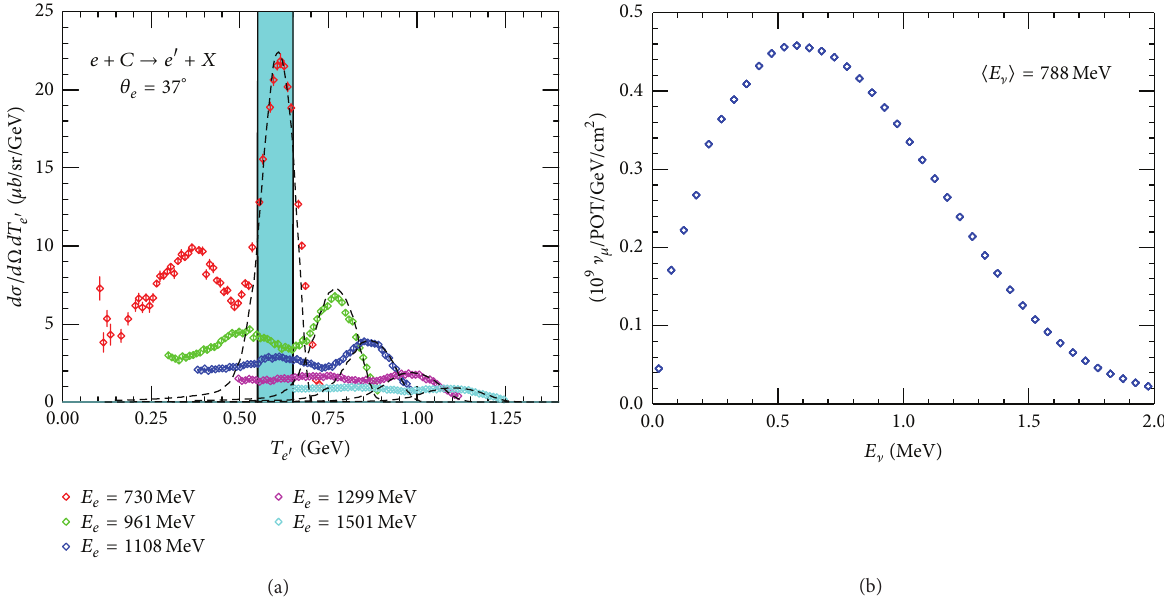
Figure 2: (a) Inclusive electron-carbon cross-sections at 𝜃 𝑒 = 37 ∘ and beam energies ranging between 0.730 and 1.501 GeV [3, 4], plotted as a function of the energy of the outgoing electron. (b) Energy dependence of the MiniBooNE neutrino flux